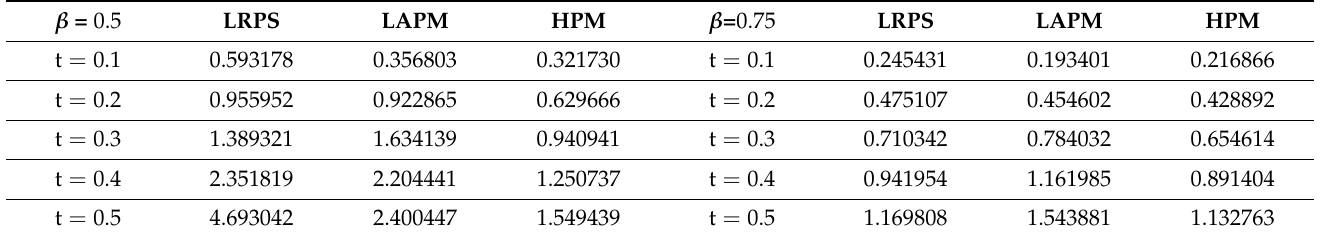
Table 1. Comparison for the solution of problems (27) and (28) with different methods for β = 0.5, β =